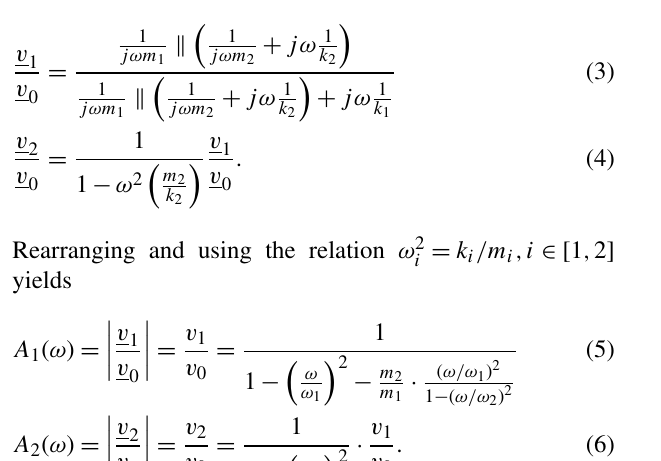
Figure 5. Amplitude curves of both cantilevers of the circuit from Fig. 4 without damping and external interaction, according to Eqs. (5) and